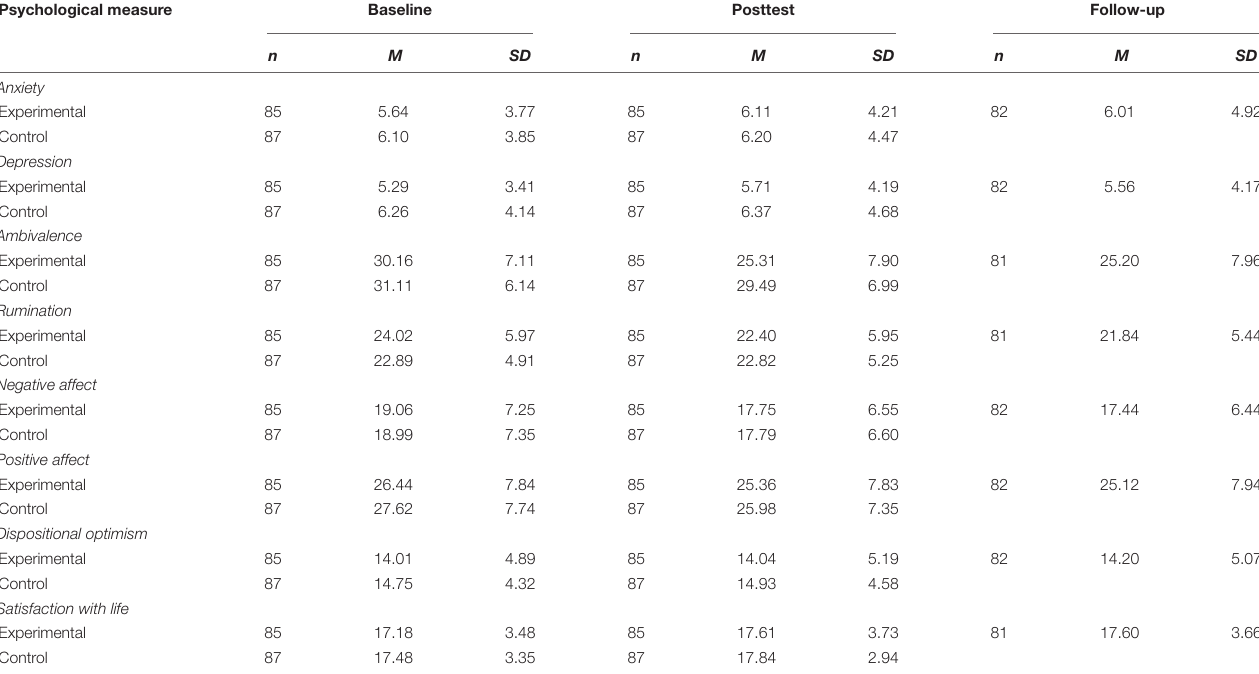
TABLE 1 | Descriptive statistics for psychological measures by group.